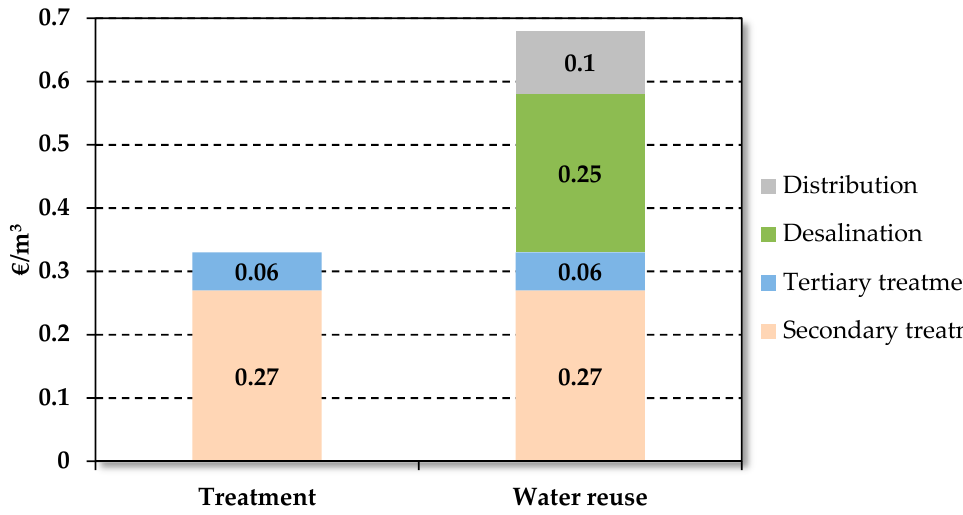
Figure 5. Cost structure of wastewater treatment and reuse in the Valencia Community (reference year: 2015). Source: elaborated with information from [83].